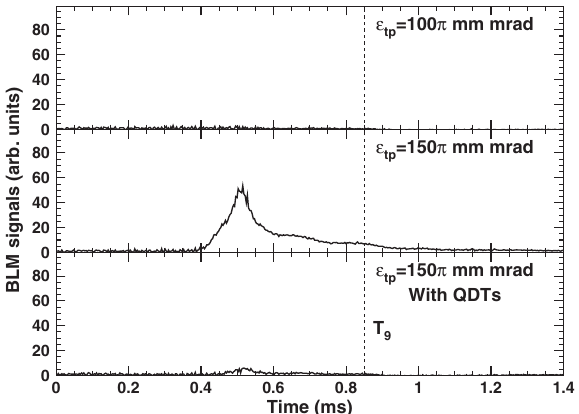
FIG. 10. Tune footprint (top) and two-dimensional transverse phase space coordinates (bottom) at the end of injection, calculated with a beam intensity of 850 kW in the case of the painting emittance of 100 π mm mrad, where three kinds of transverse beam distributions are given: (a) without edge focus, (b) with edge focus, and (c) with the addition of QDTs to